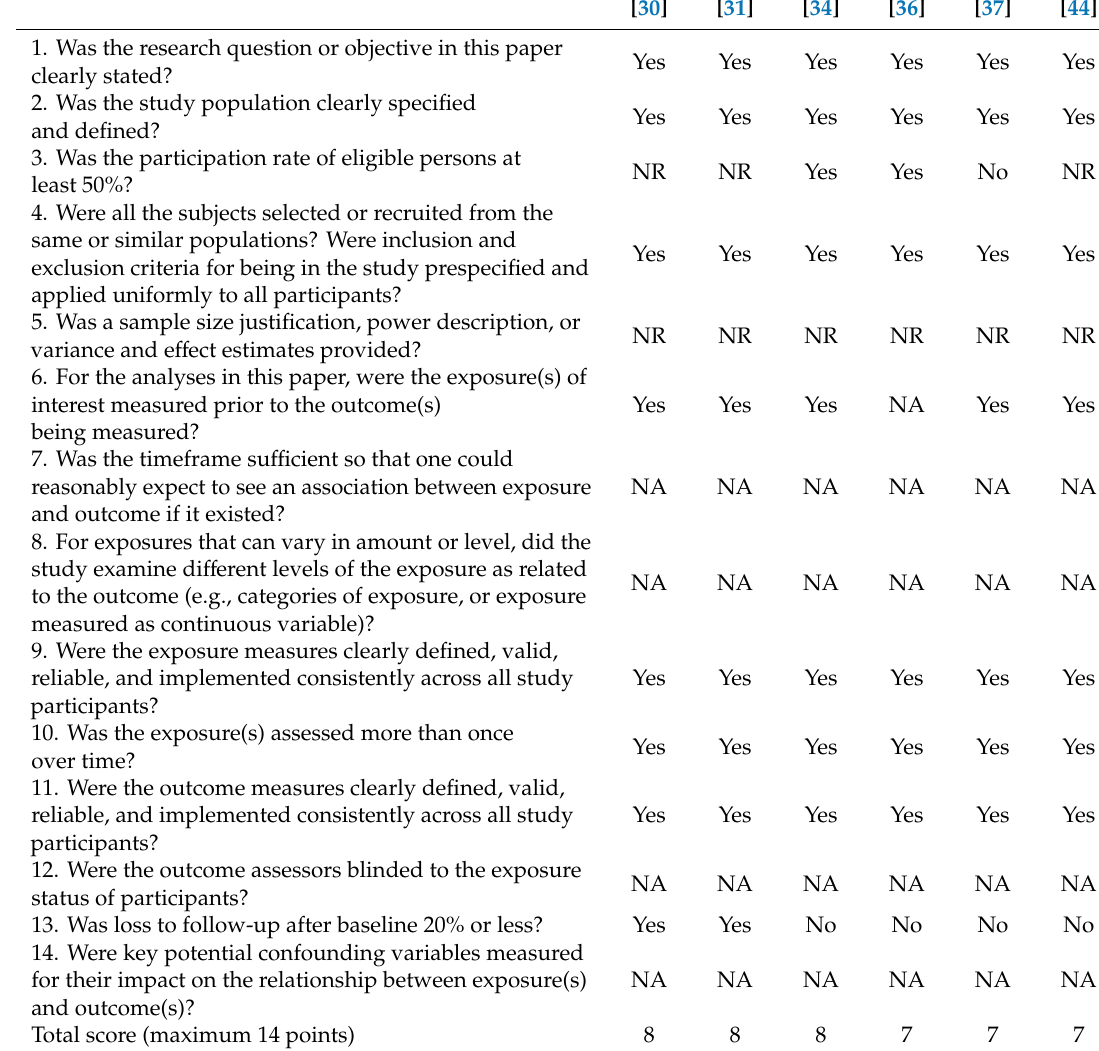
Table 6. Quality assessment of observational cohort and cross-sectional